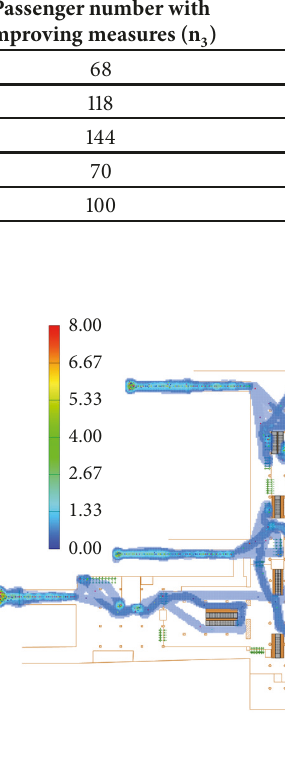
Figure 6: Crowd density map with security checks (in 5